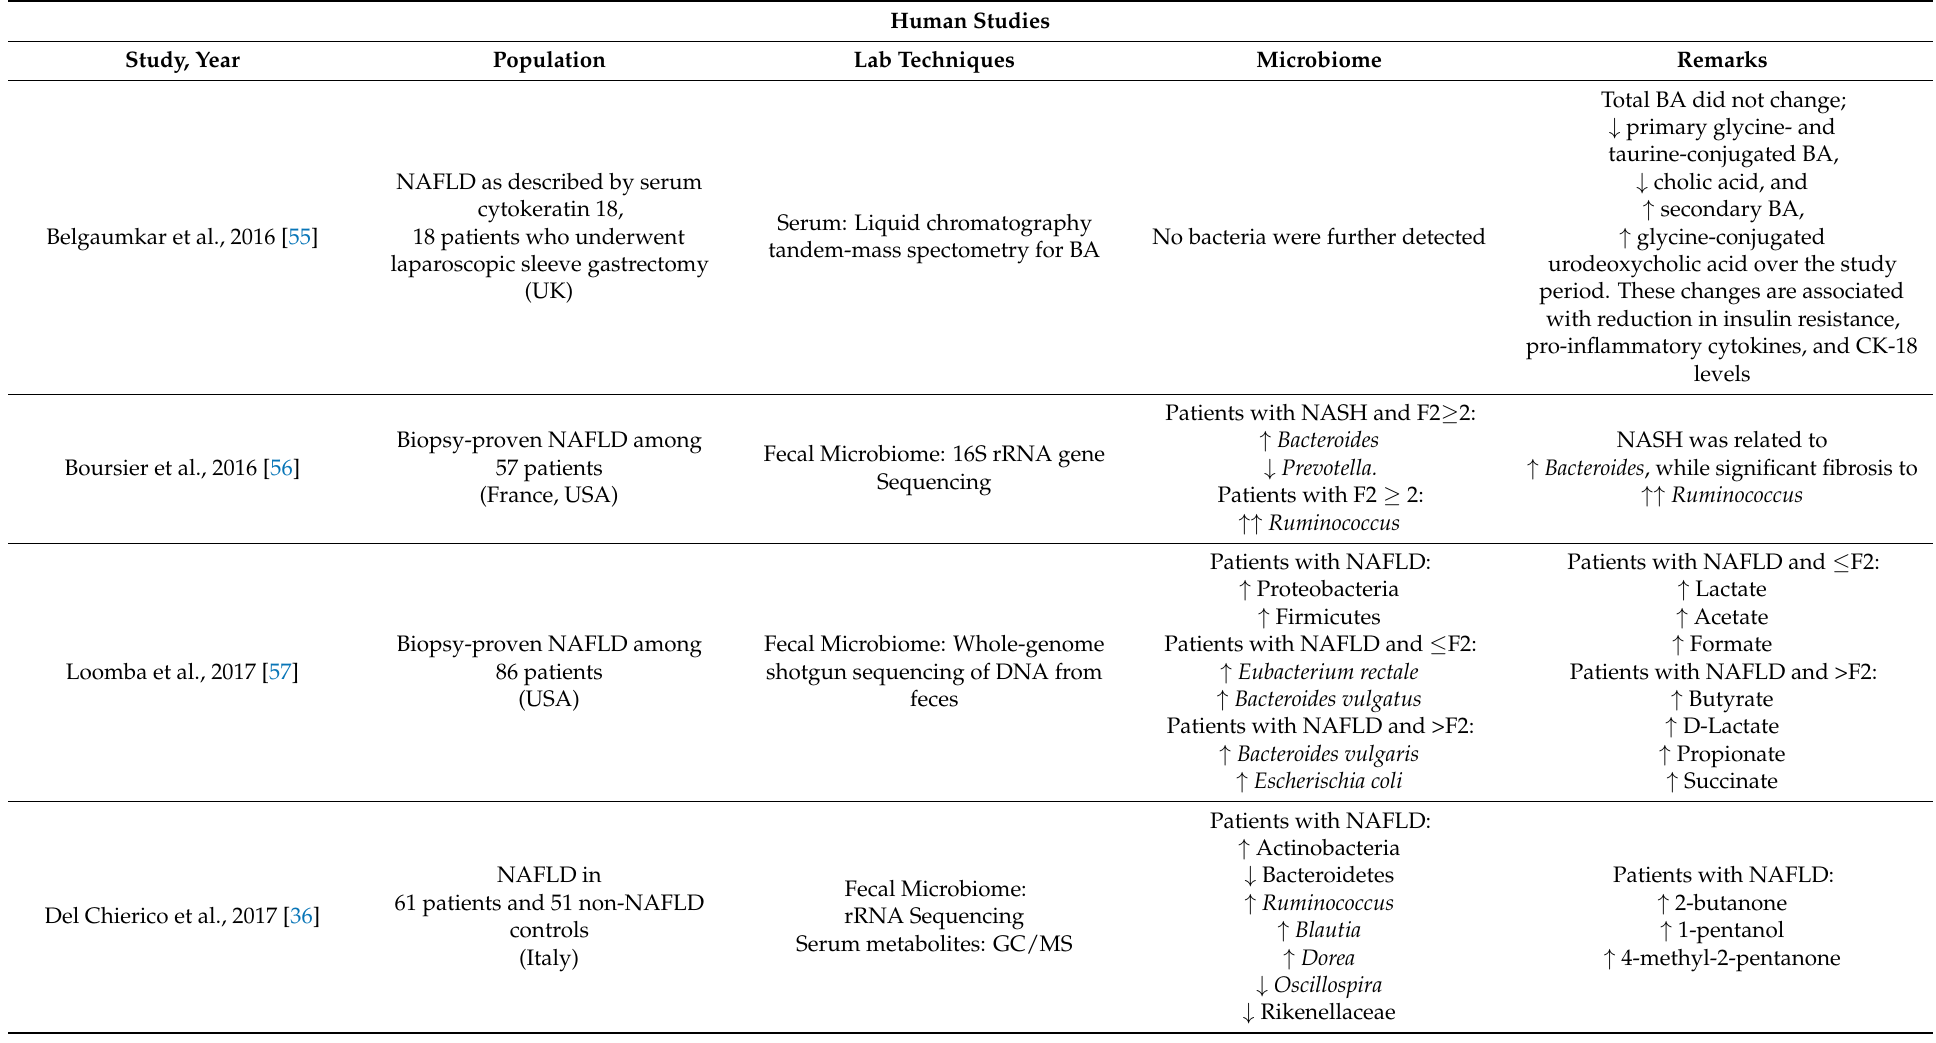
Table 2. Evidence from human studies depicting associations of various bacterial species and metabolic signatures in patients with